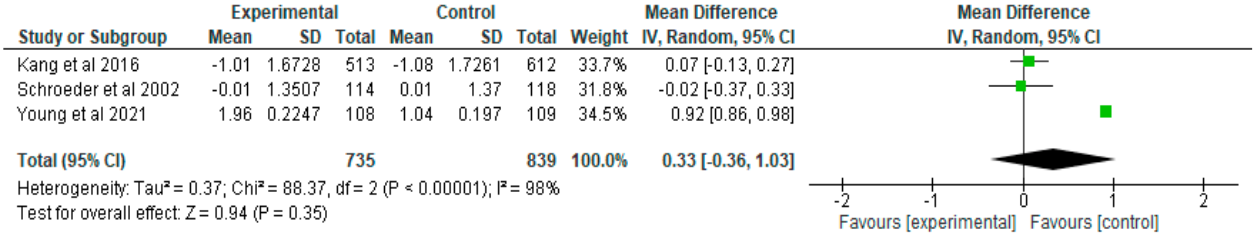
Figure 4. Results pooled data on the e ff ect of positive deviance interventions on LAZ